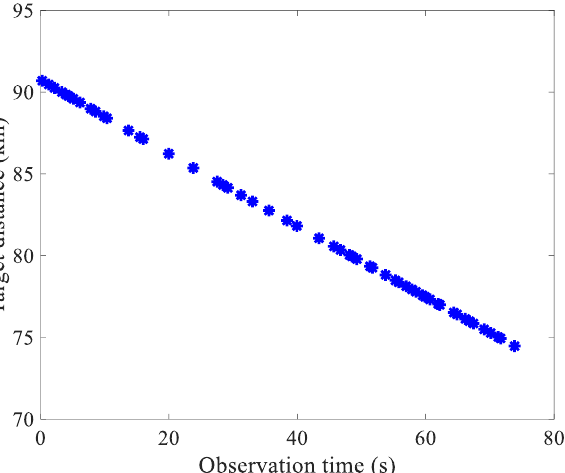
Figure 4. The ground truth of target direction recorded by the global position system across the observation time.